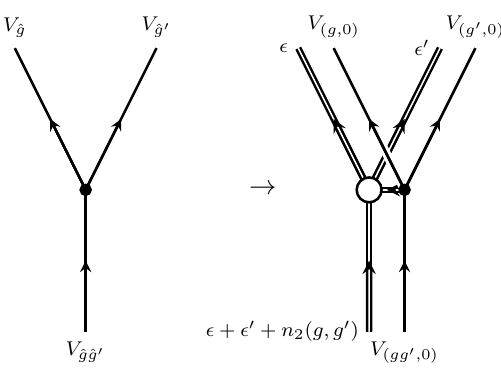
’ V (cid:10) V g; 0 ( g;(cid:15) ) (1 ;(cid:15) )